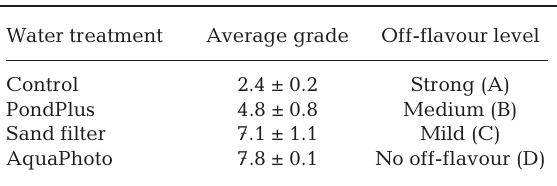
4. Off-flavour profiling of pangas from ponds with dif- ferent treatment. Numeric scores of grades (see Table 1) are mean ± SE; n = 48 (12 from each pond treatment). The grad- ing was statistically different for each water treatment type (p < 0.05; ANOVA)